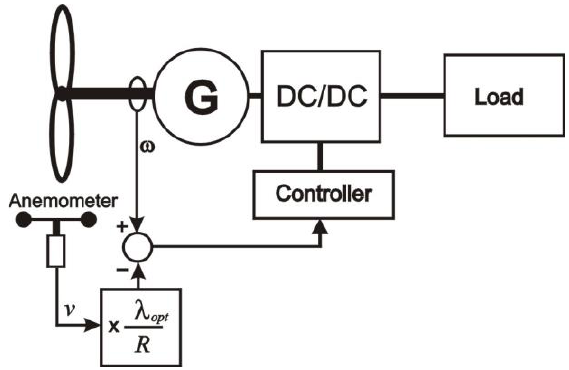
Figure 4. Tip speed ratio control.